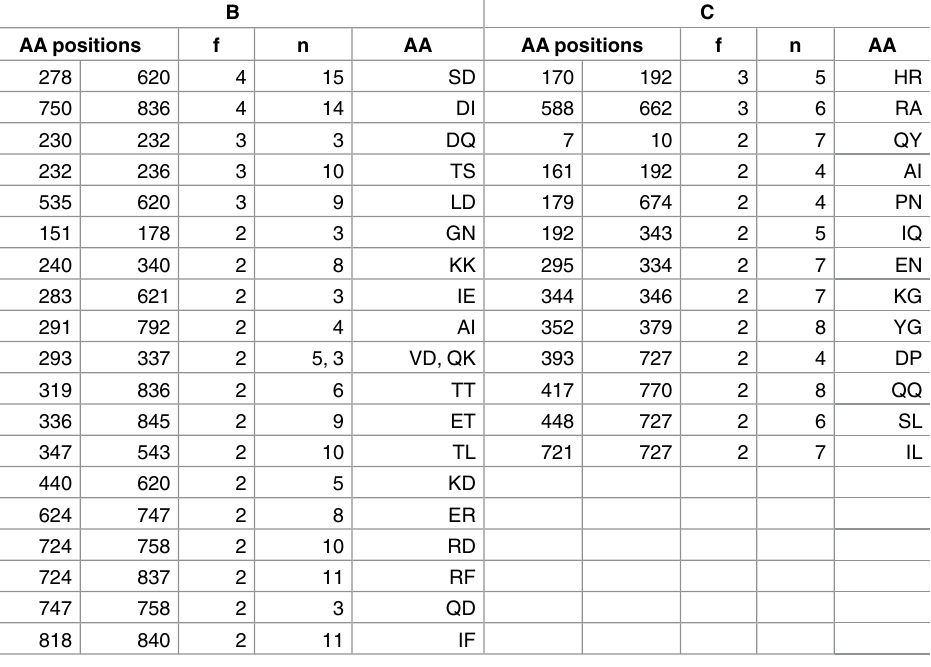
Table 1. Pairs observed multiple times (frequency f) in optimal networks for each subtype. The num- ber of individuals exhibitingeach AA combination is denotedby n. B C AA positions